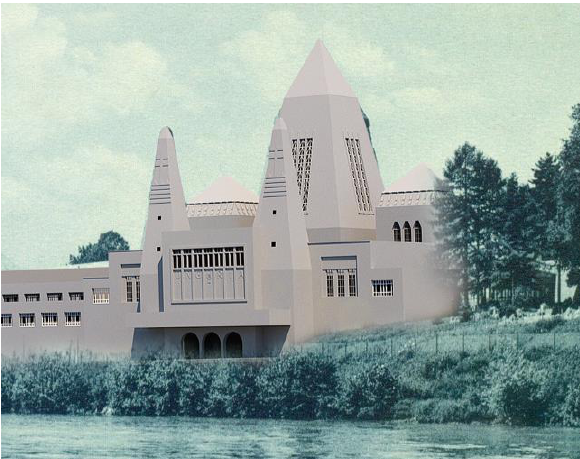
Figure 12. Final 3D model of the Pavilion of